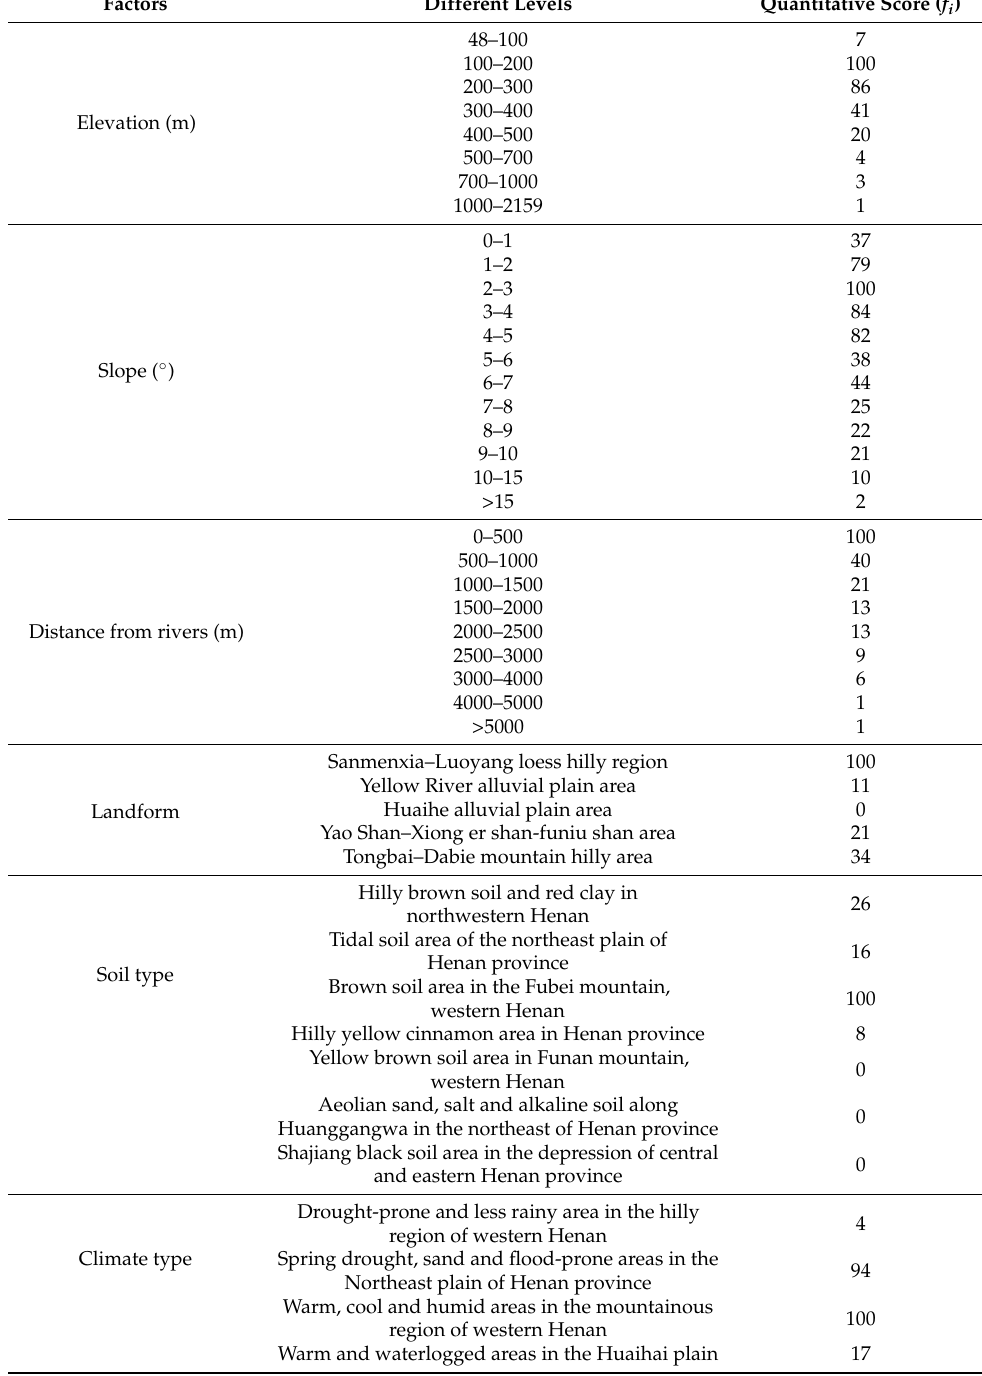
Table 8. Scores with different factors and